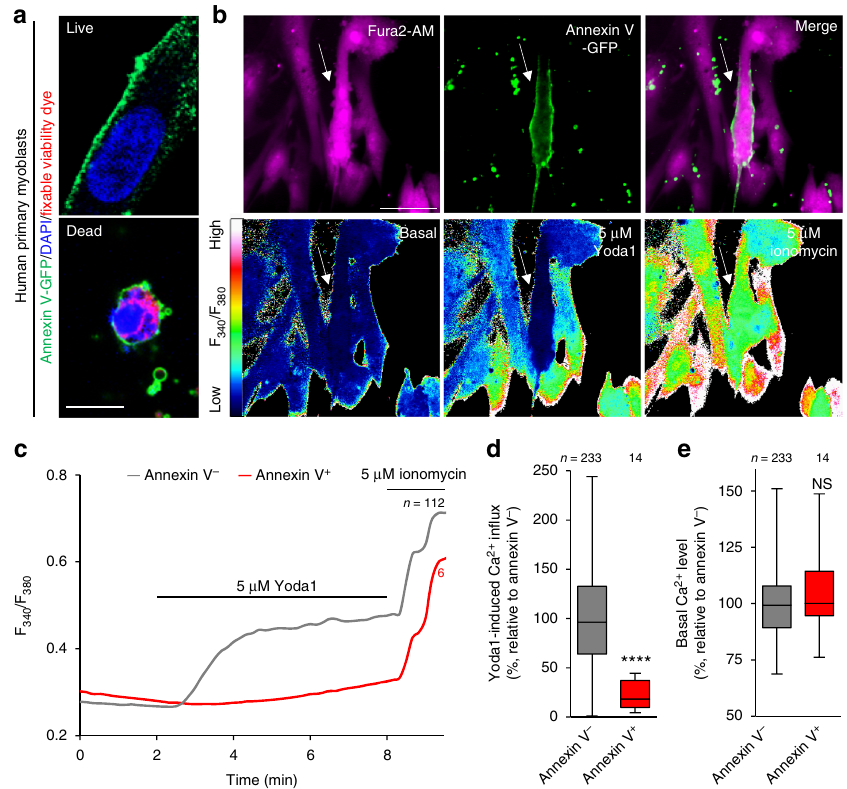
Fig. 4 Impaired PIEZO1 activation in PS-exposing human primary myoblasts during myotube formation. a Detection of cell surface-exposed PS on differentiating human primary myoblasts by annexin V-GFP (PS, green), DAPI (nuclei, blue) and fi xable viability dye (dead cells, red). b Fura2 imaging of Ca 2 + in fl ux in annexin V-GFP-labelled human primary myoblasts (arrow) upon addition of Yoda1 and ionomycin. Representative traces ( c ), quanti fi cation of Yoda1-induced Ca 2 + in fl ux ( d ) and basal Ca 2 + level ( e ) in b . **** P < 0.0001 (Student ’ s t -test). NS not signi fi cant, n sample number. Box and whiskers graph ― line: median, box: upper and lower quartiles, whiskers: maxima and minima. Scale bars: 10 μ m ( a ), 20 μ m ( b